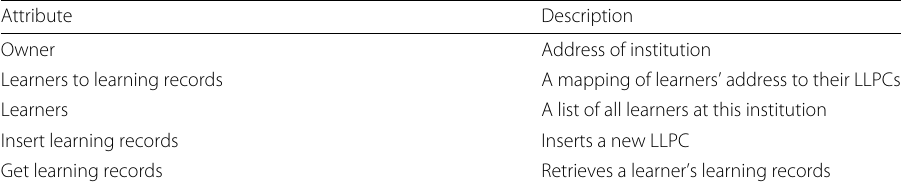
Table 3 Provider index contract